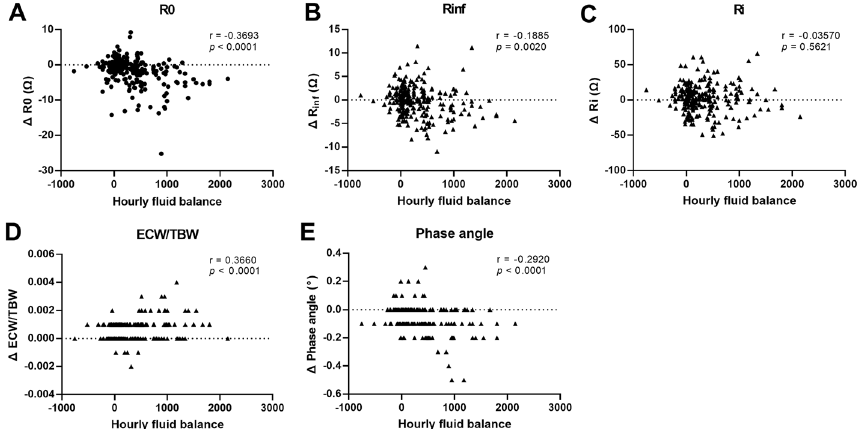
Fig. 3 Pearson’s correlation analyses between changes of resistances (ΔR 0 ( A ), ΔR inf ( B ), and ΔR i ( C )), ECW/ TBW ( D ), and phase angle ( E ) with fluid balance. Correlation coefficient r values with p values are denoted in each graph. ECW extracellular water, TBW total body